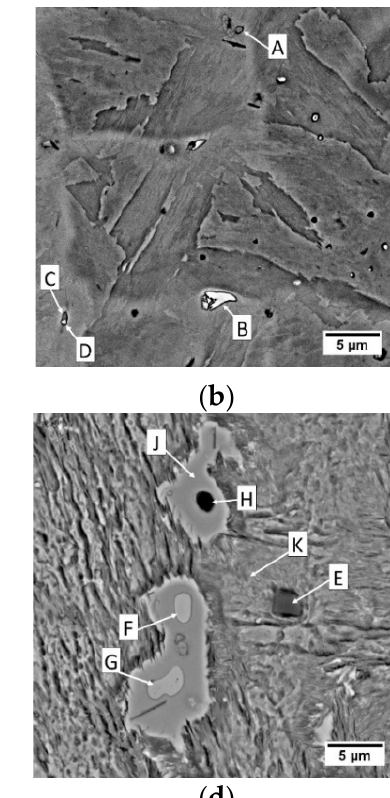
Figure 4. Microstructure of wire arc additive manufactured 18Ni-12Co-4Mo-Ti maraging steel in the: ( a , b ) 10th layer, ( c , d ) 6th layer. 4% Nital etched.